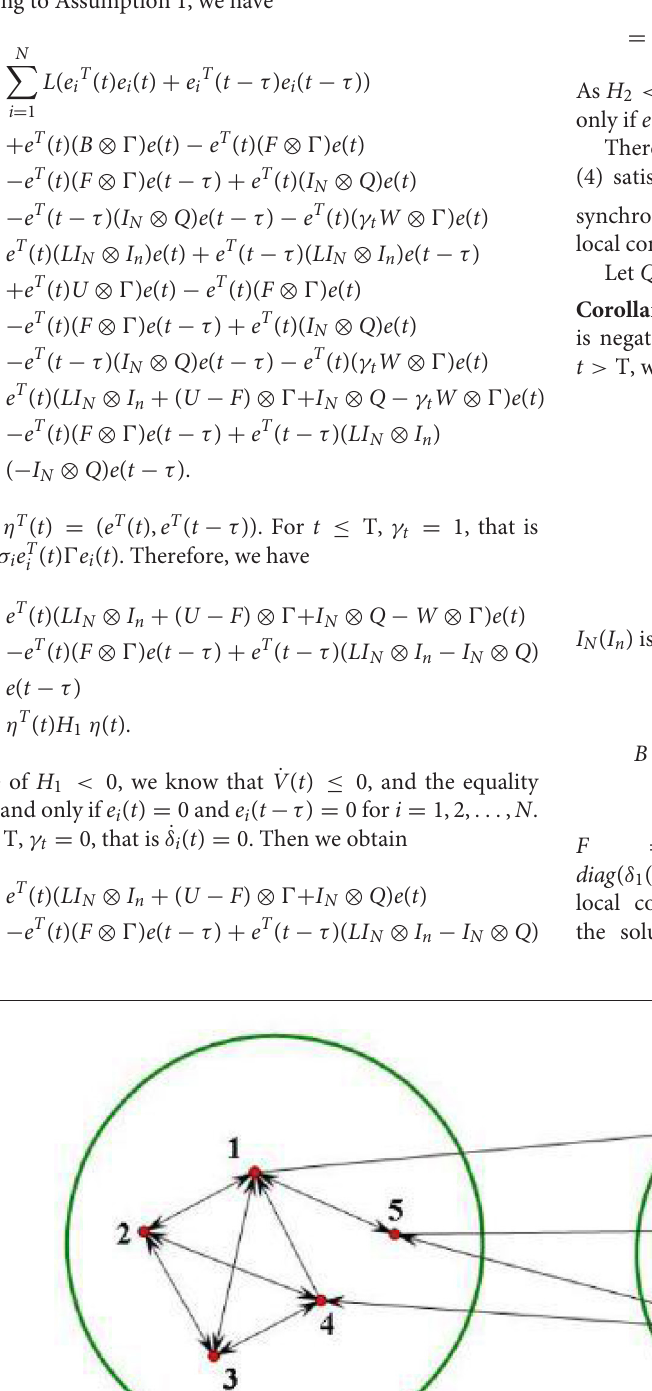
Frontiers in Physics |